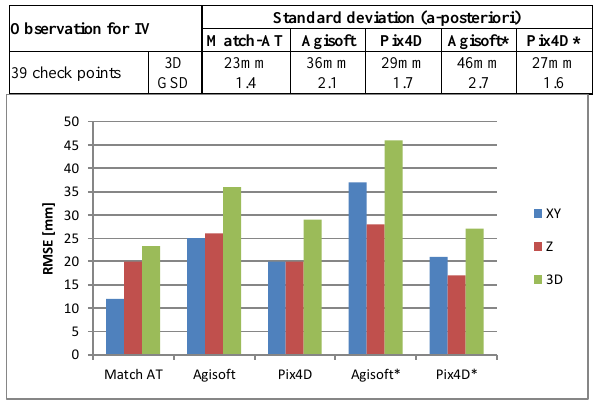
Figure 15: RMSE results at 39 check points (configuration